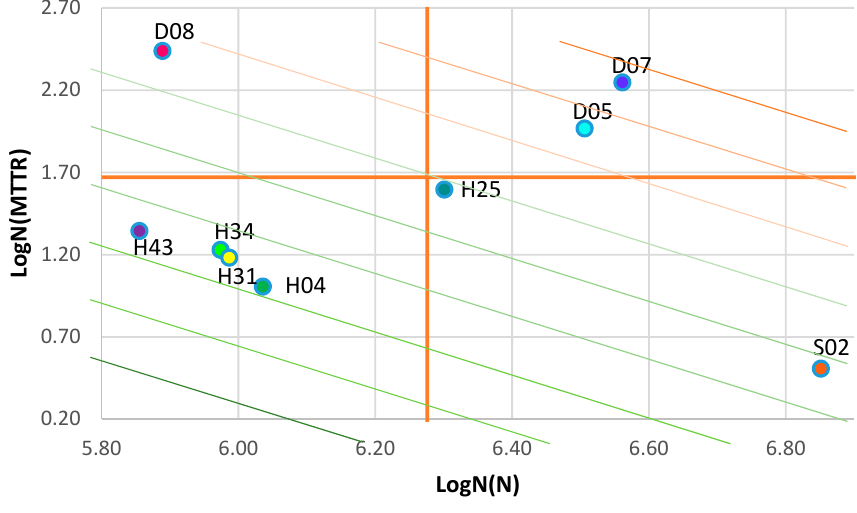
Figure 8. Jack knife diagram.